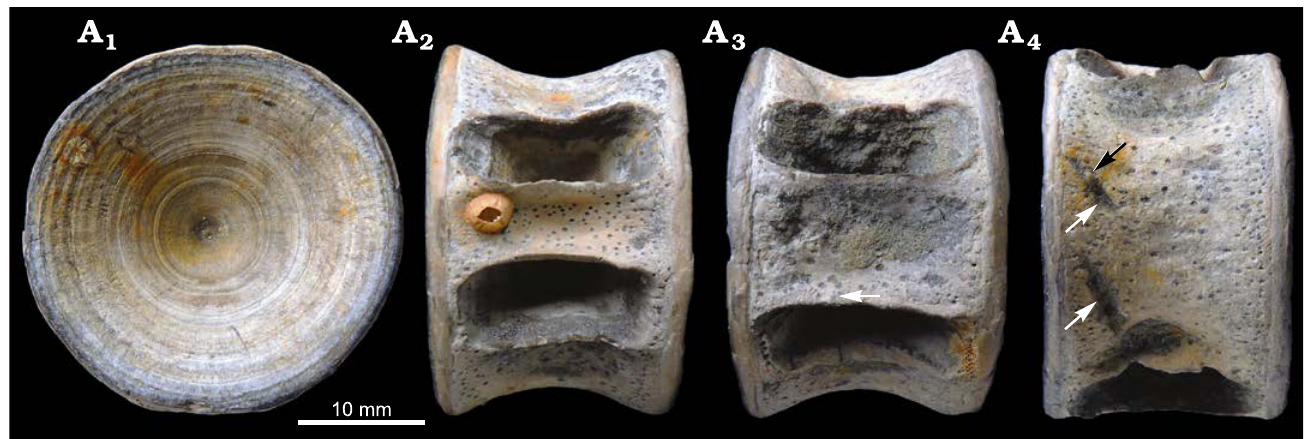
Fig. 3. Centrum of Carcharhinidae indet. (CMM-V-7012) from the Miocene Calvert Formation near Prince Frederick, MD, USA, in articular (A 1 ), dorsal (A 2 ), ventral (A 3 ), and lateral (A 4 ) views. Arrows mark the location of bite traces.